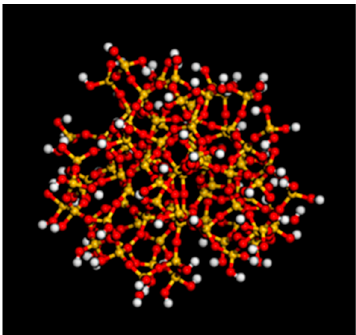
Figure 1. SiO 2 nanoparticle without broken bonds on the surface.